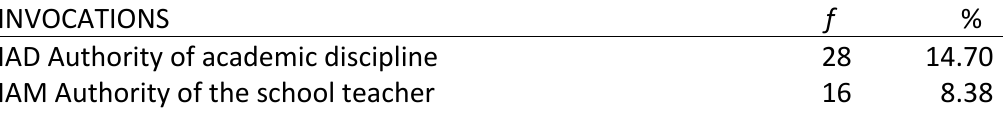
Table 6. Overall profile of invocations in case